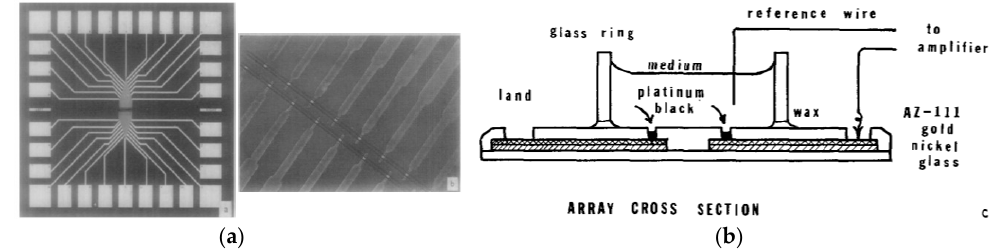
Figure 6. One of the first examples of microelectrode array. ( a ) Left: full photolithographied array and its contacts; right: zoom-in of the arrayed platinum black electrodes forming the floor of the well; ( b ) scheme of the device. Reprinted from Thomas et al. [65]. Copyright © 1972, with permission from Elsevier.